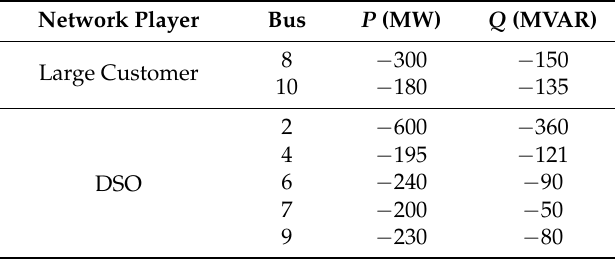
Table 7. Changes to the original benefit of